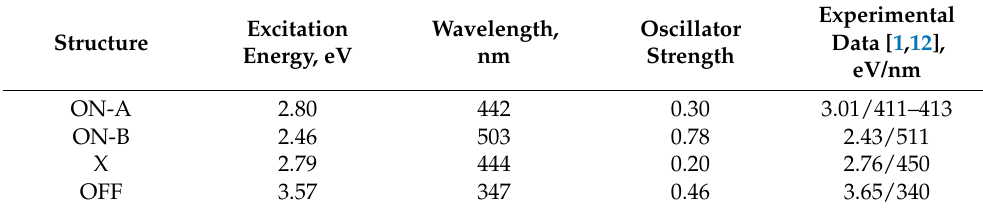
Table 1. Comparison of the computed S 0 → S 1 excitation bands and experimental absorption bands. Structure ON-A refers to the protein in the ON-state with the neutral Chro (Figure 3b); structure ON-B refers to the ON-state with the anionic Chro (Figure 3c).